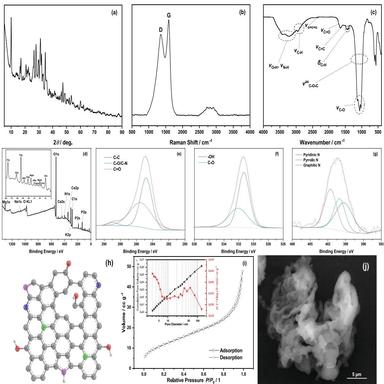
Structure and morphology of BC. (a) XRD pattern; (b) Raman spectrum; (c) FTIR spectrum; (d) XPS survey spectrum; (e) XPS C1s spectrum; (f) XPS O1s spectrum; (g) XPS N1s spectrum; (h) simplified schematic diagram (gray balls for C, red balls for O, white balls for H, blue balls for N-6, violet balls for N-5, green balls for N-G); (i) N2 BET isotherm adsorption-desorption curve (Inset figure: pore size distribution diagram); (j) SEM image of BC.